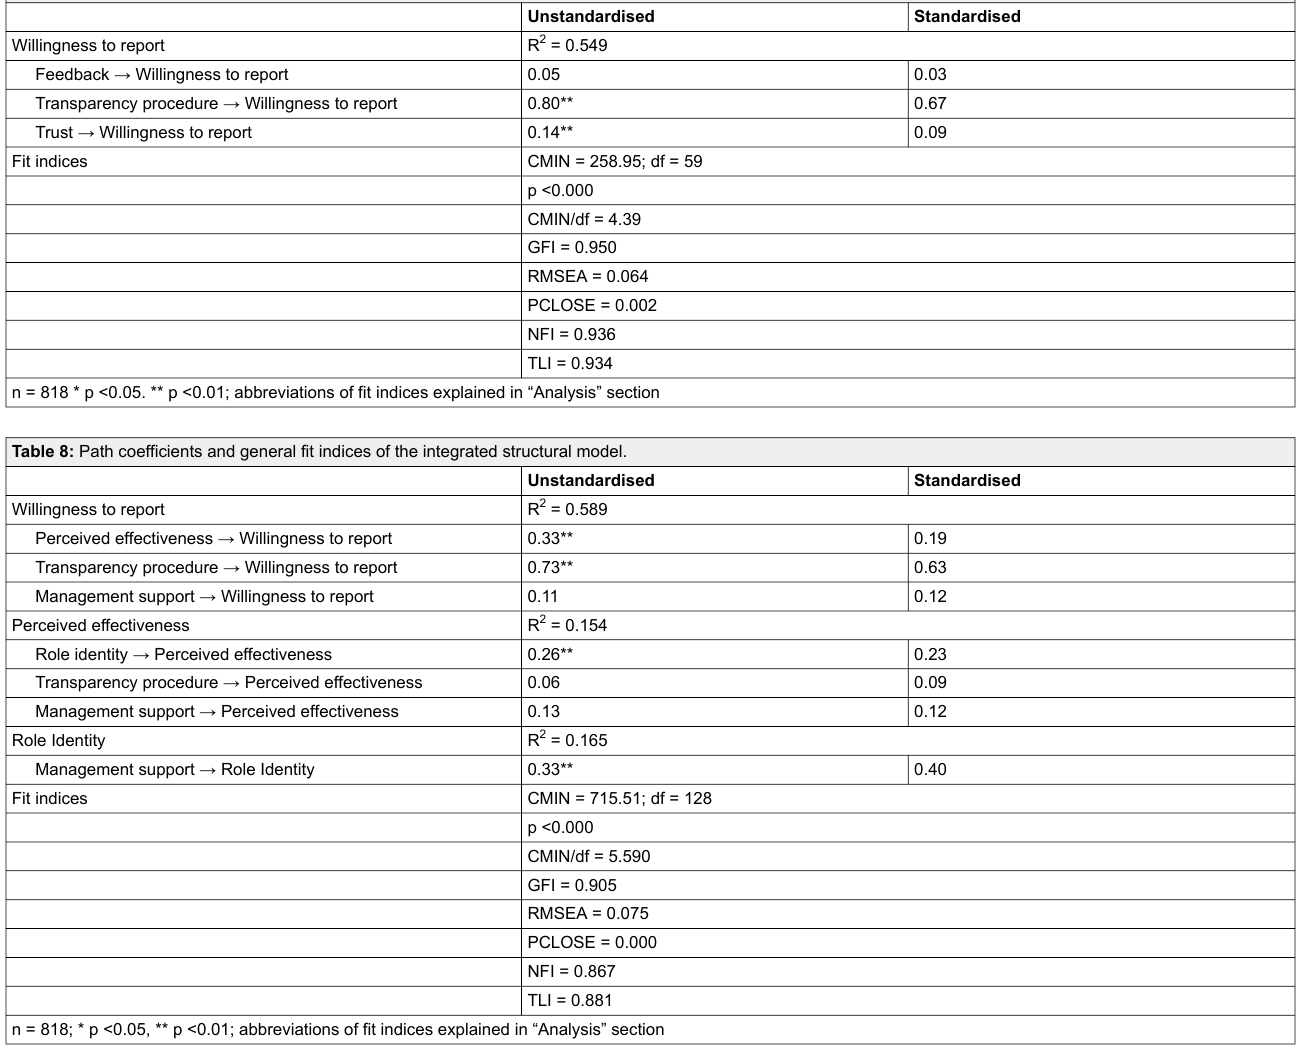
Table 7: Path coefficients and general fit indices of the structural model: IRS-related impacts.